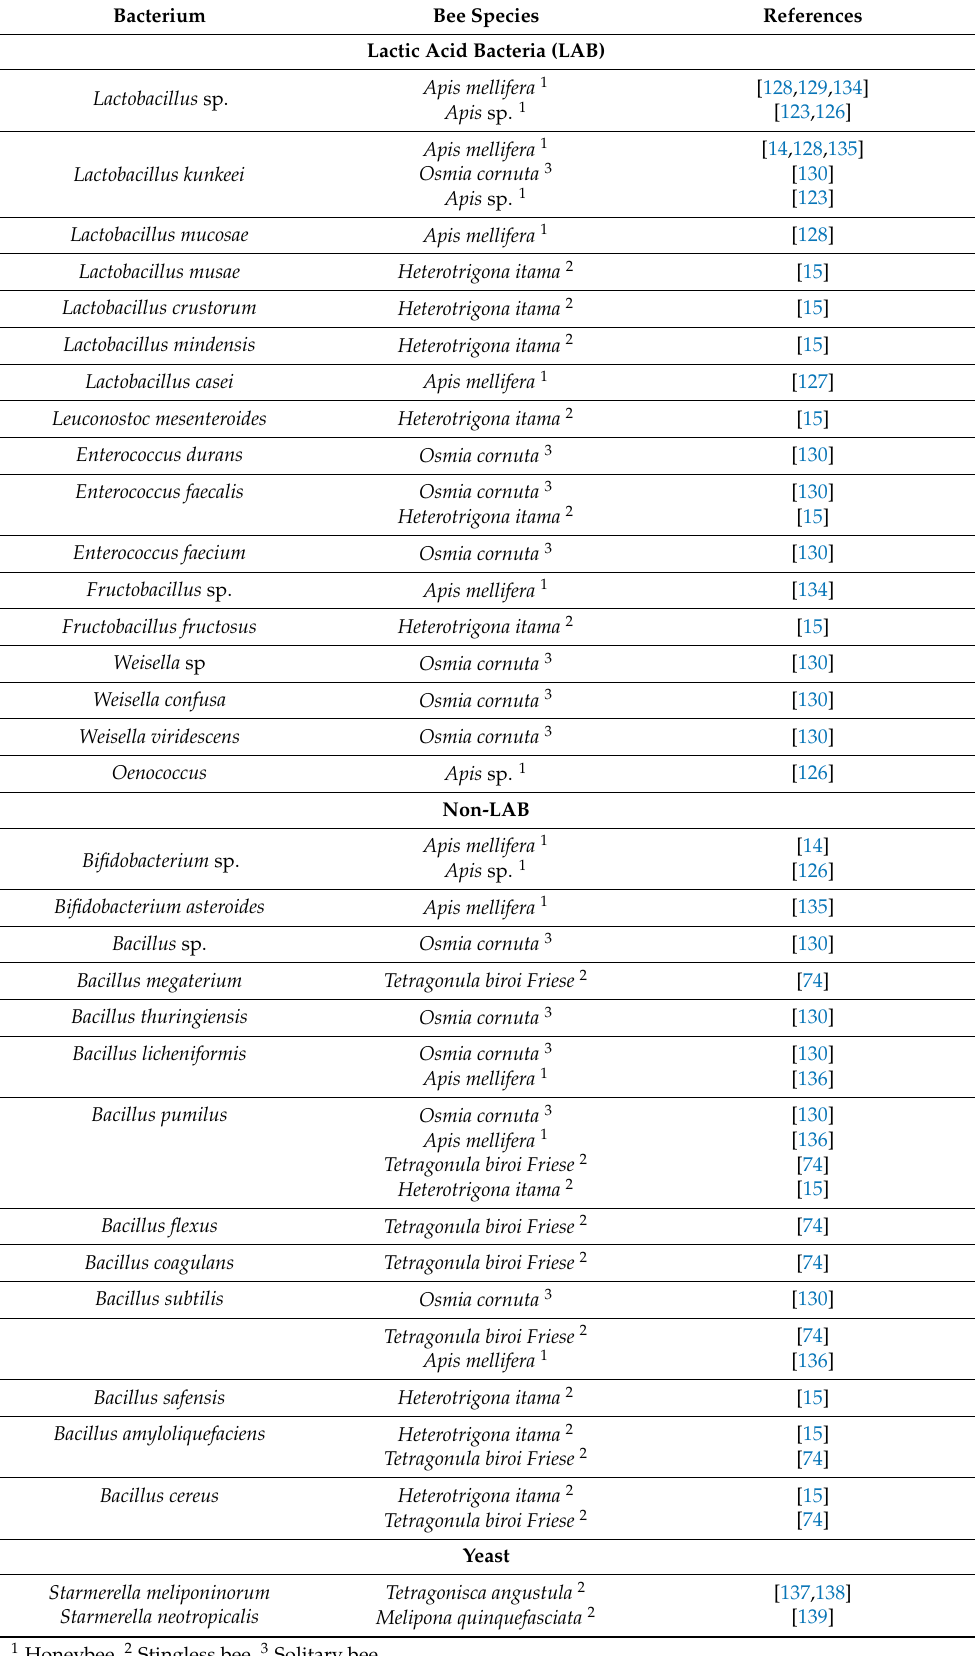
Table 7. Lactic acid bacteria, nonlactic acid bacteria, and yeasts associated with stingless bee bee